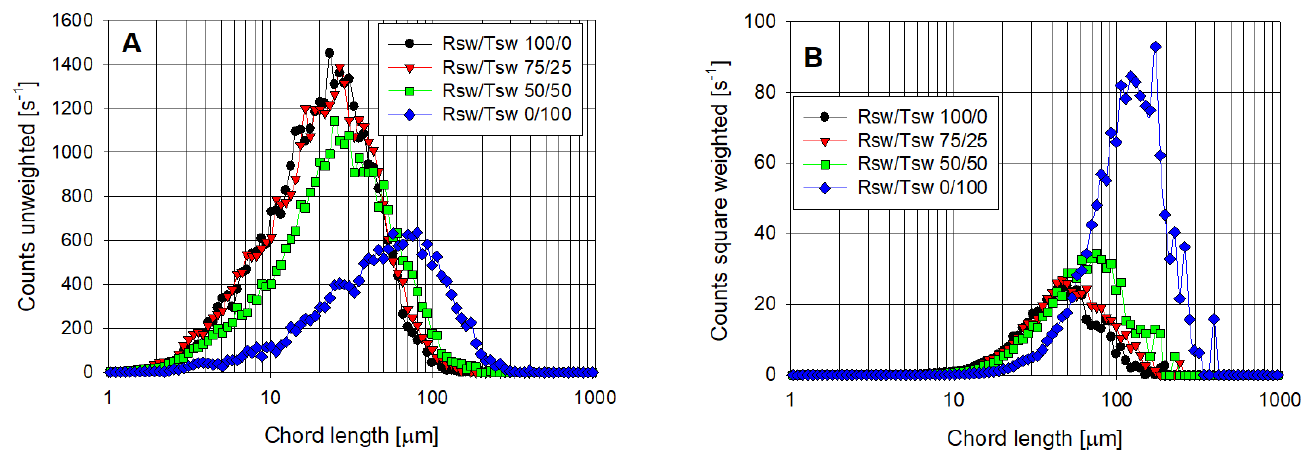
Figure 8. ( A ) unweighted and ( B ) square-weighted chord length distributions from the flocculation of synthetic tailings in raw seawater (Rsw) and treated seawater (Tsw). Tailings 2 (Qz/Kao 75/25), solid concentration 10 wt%, flocculant dosage 20 g/t, flocculation time 90 s (after dosing).